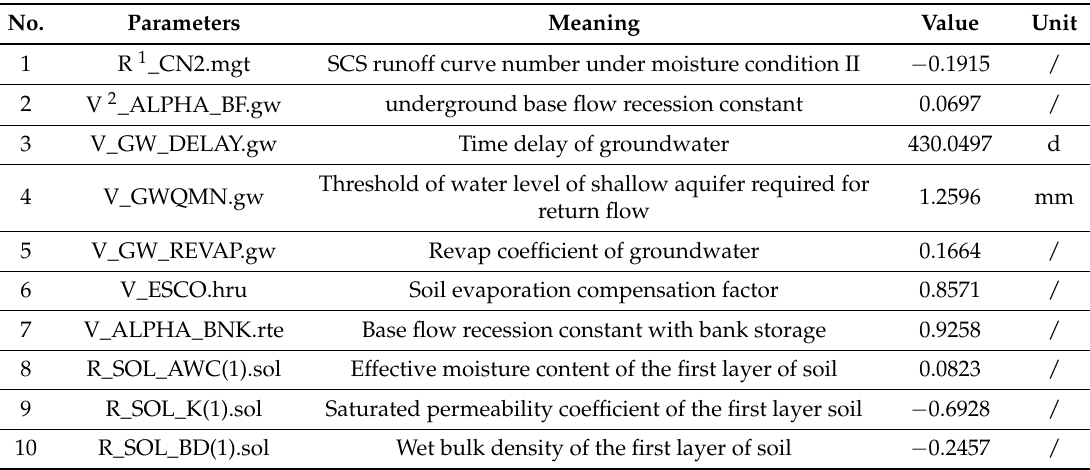
Table 2. The parameters calibrated in the study.